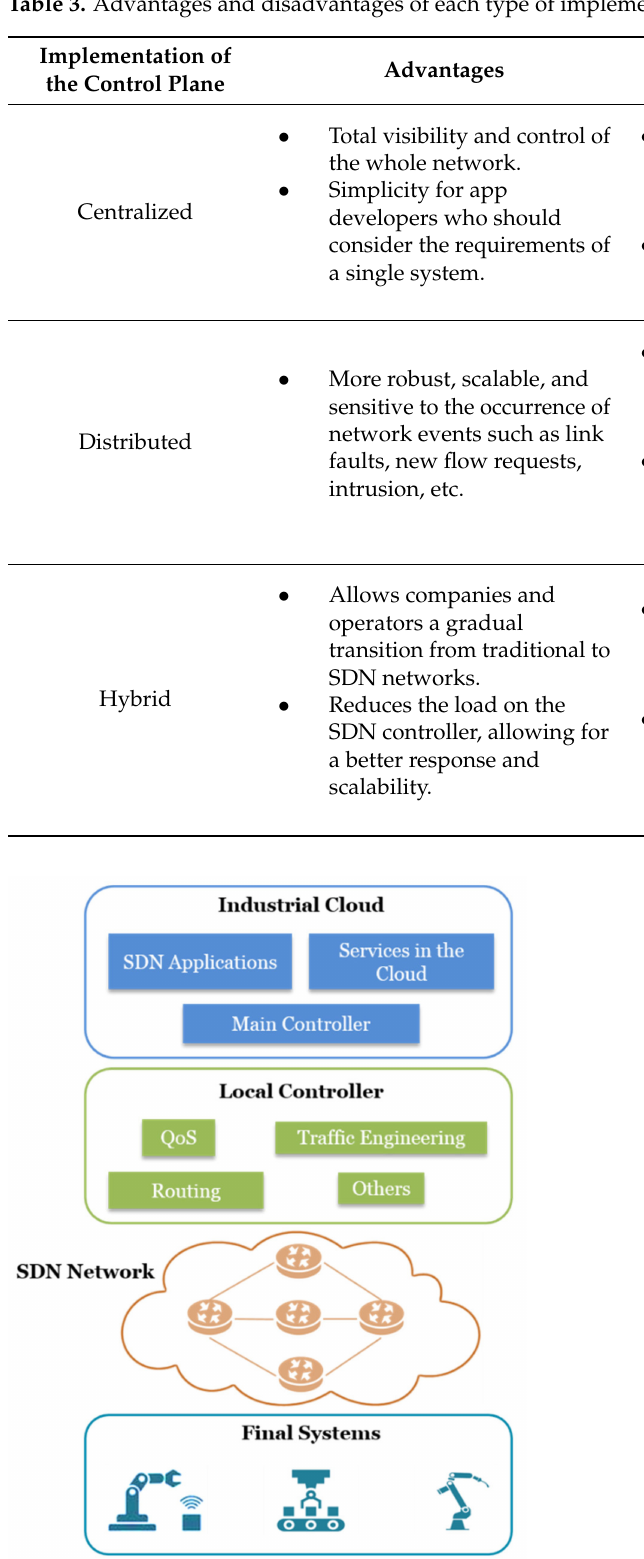
Table 3. Advantages and disadvantages of each type of implementation in the control plane.